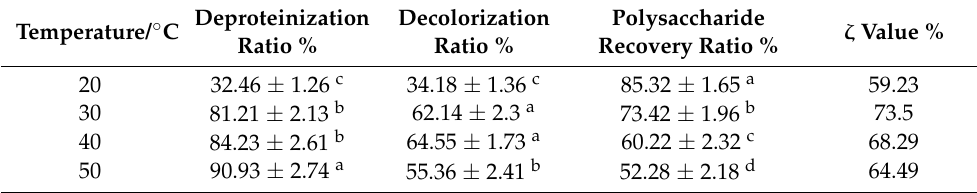
Table 5. Effect of temperature on decoloration ratio, deproteinization ratio, polysaccharide recovery ratio, and selectivity coefficients of A-722MP